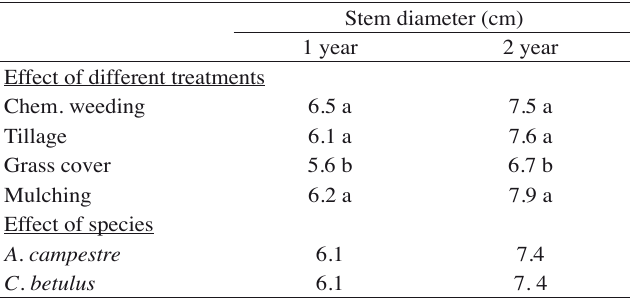
Table 3 - Effects of soil management technique and species on stem diameter growth in the first and second years